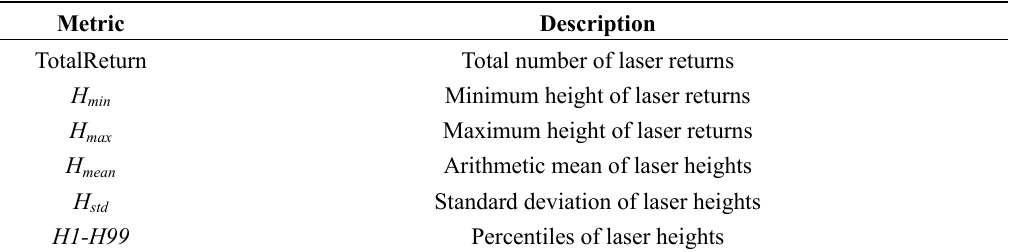
Table 2. Metrics calculated from MLS data.